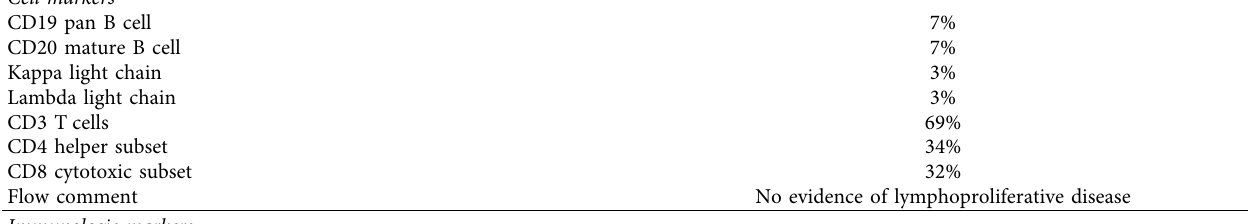
Table 5: Immunologic and cell markers, including flow cytometry profile and genetic